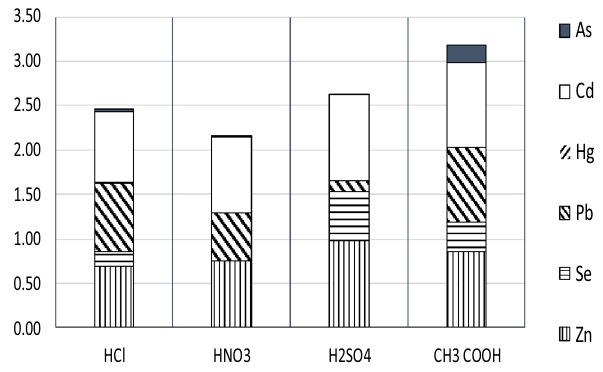
Fig. 6 Becker tests: sum of final extraction yield obtained in the preliminary tests